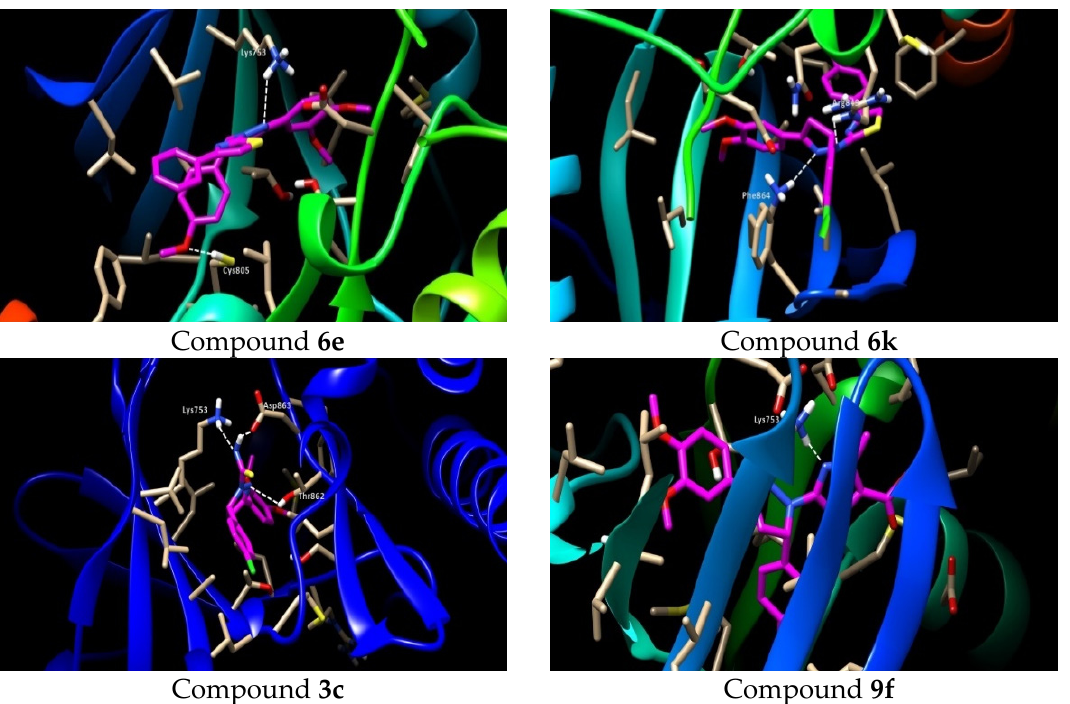
Figure 11. Binding interactions of the promising derivatives ( 6e , 6k , 3c , and 9f ) in the HER2 receptor (3RCD) showing ligands (magenta) and H bonds (white-dashed). (3RCD) showing ligands (magenta) and H bonds